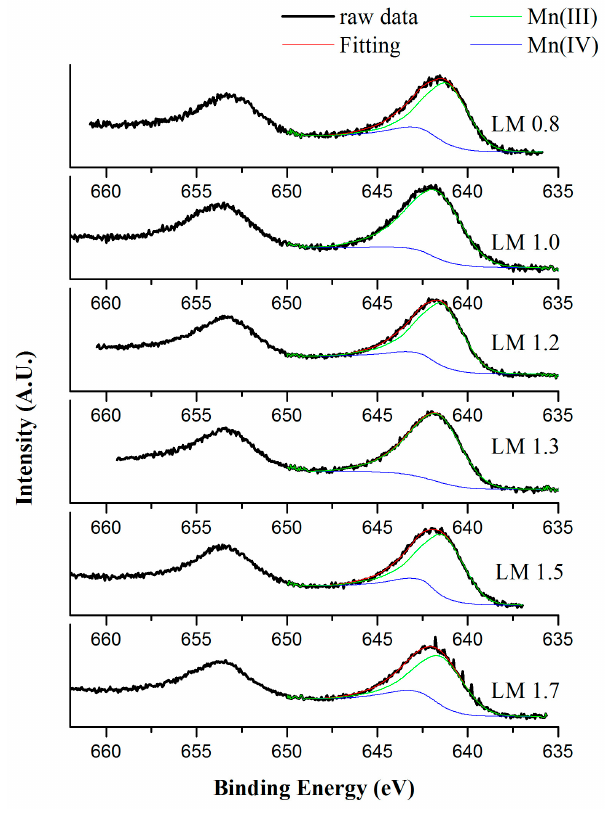
Figure 7. Experimental and fitted Mn2p XP spectra for selected LM samples.